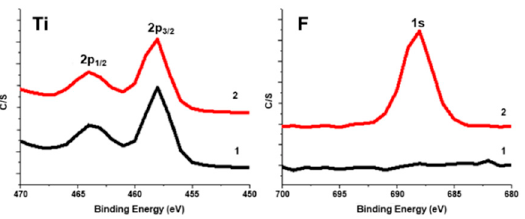
Figure 1. XPS spectra of platinized TiO 2 ( 1 ) and Nafion-coated Pt-TiO 2 ( 2 ) in the Ti 2p (left) and F 1s band regions.